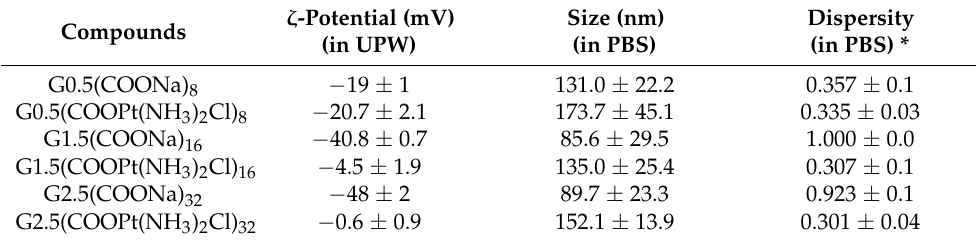
Table 1. ζ -potential, size, and dispersity of anionic PAMAM dendrimers (G0.5-G3.5) and their related metallodendrimers after conjugation with cisplatin in a monodentate form. ζ -Potential (mV) Size (nm) Dispersity Compounds (in UPW) (in PBS) (in PBS) * G0.5(COONa)